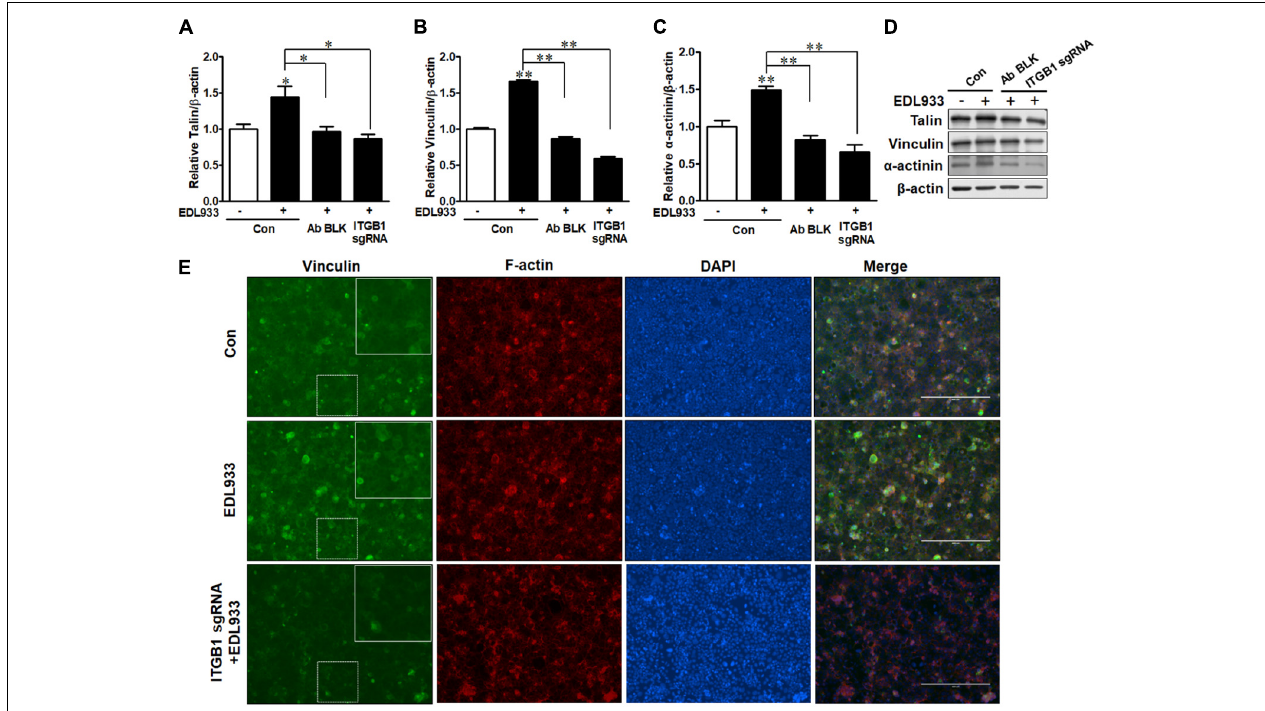
FIGURE 3 | Focal adhesions were recruited upon E. coli O157:H7 infection in an integrin β 1-dependent manner. (A–D) Immunoblotting analysis of talin, vinculin, and α -actinin. (E) Immunofluorescence staining for vinculin. Caco-2 cells were immuno-blocked with integrin β 1 antibody (Ab BLK) or transfected with integrin β 1 sgRNA (ITGB1 sgRNA) plasmid followed by infection with EDL933 strain for 4 h. Con. Caco-2 cells without infection; EDL933, Caco-2 cells infected with EDL933 strain; ITGB1 sgRNA + EDL933, integrin β 1 knockout Caco-2 cells infected with EDL933 strain. Blue, DAPI; Red, F-actin; Green, vinculin. Images were taken at 100 × magnification. Means ± SEM; n = 4. ∗∗ P ≤ 0.01; ∗ P ≤ 0.05.